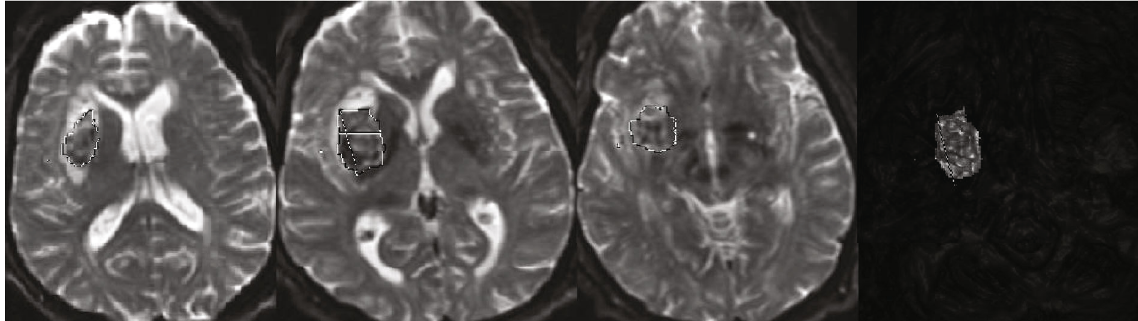
Figure 1: T2WI axial section showing hemorrhage segmentation at the beginning of the examination (red outline), with a 3D reconstruction at the same